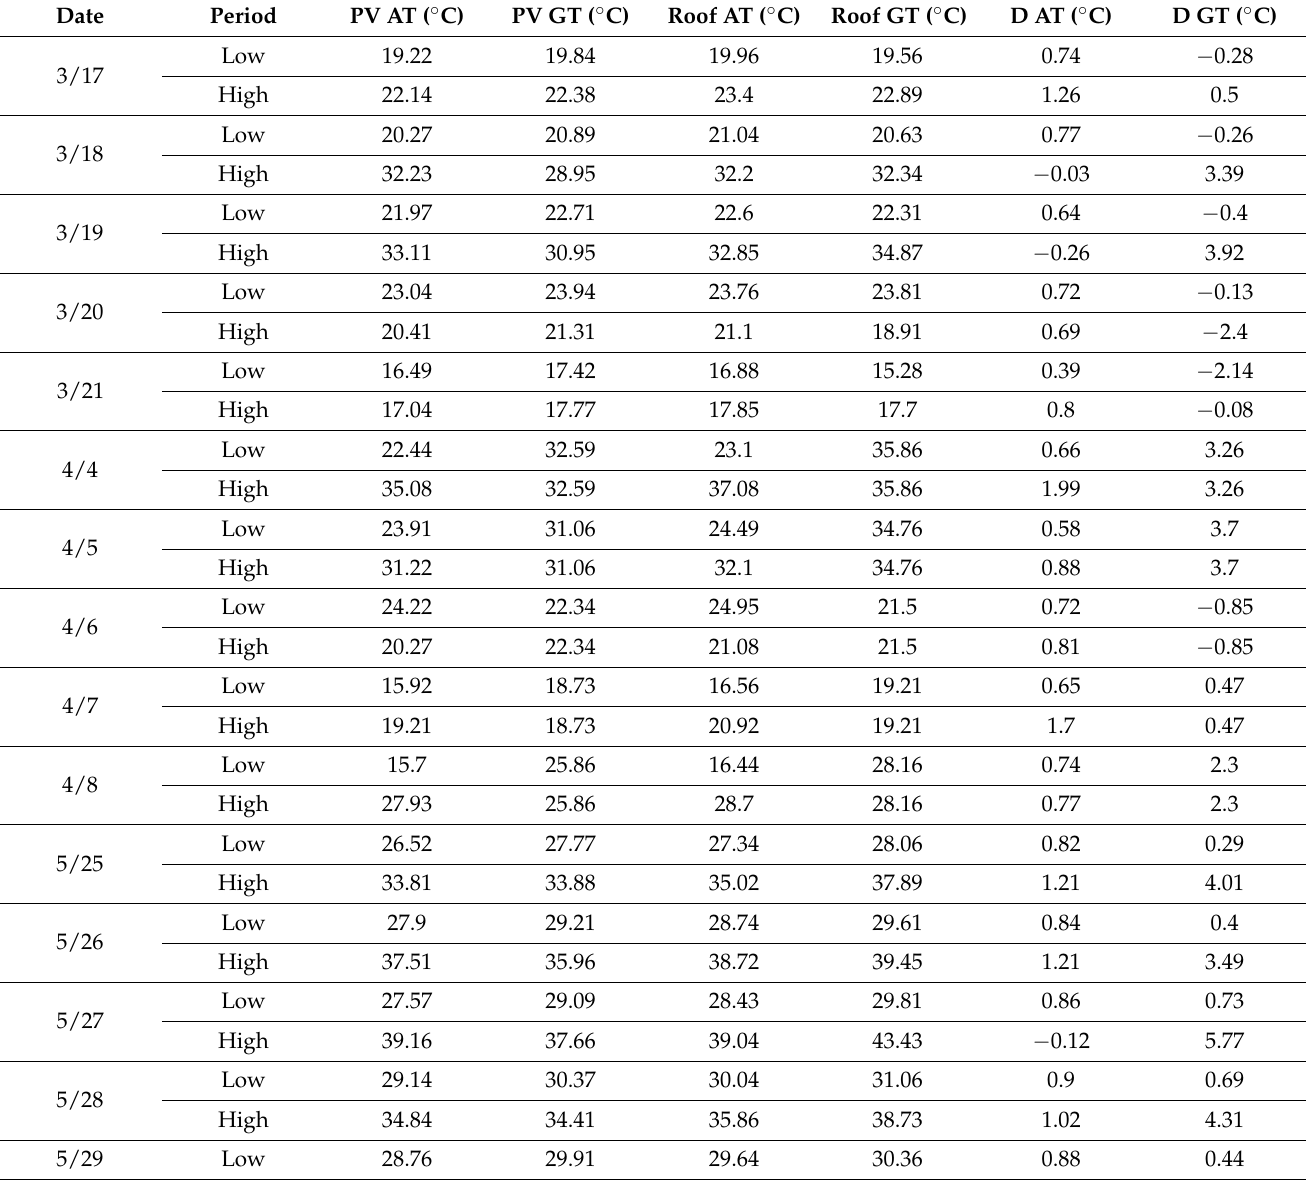
Table 5. Shading effect of the photovoltaic